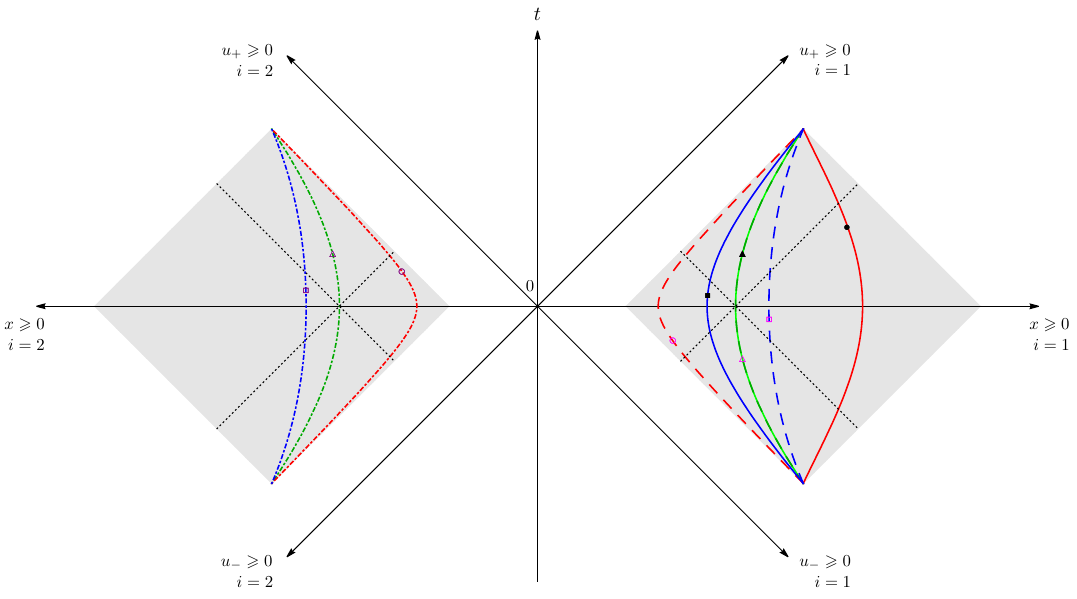
Figure 4 . Three sets of conjugated modular trajectories in the spacetime for the modular flow of the Dirac field in the presence of a defect in the origin (see